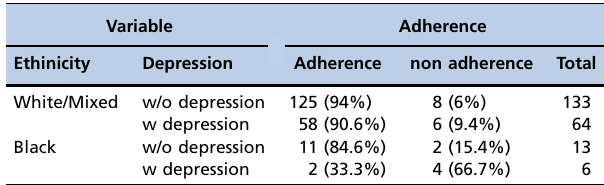
Table 6 - Observed distribution of adherence per ethnicity and depression.